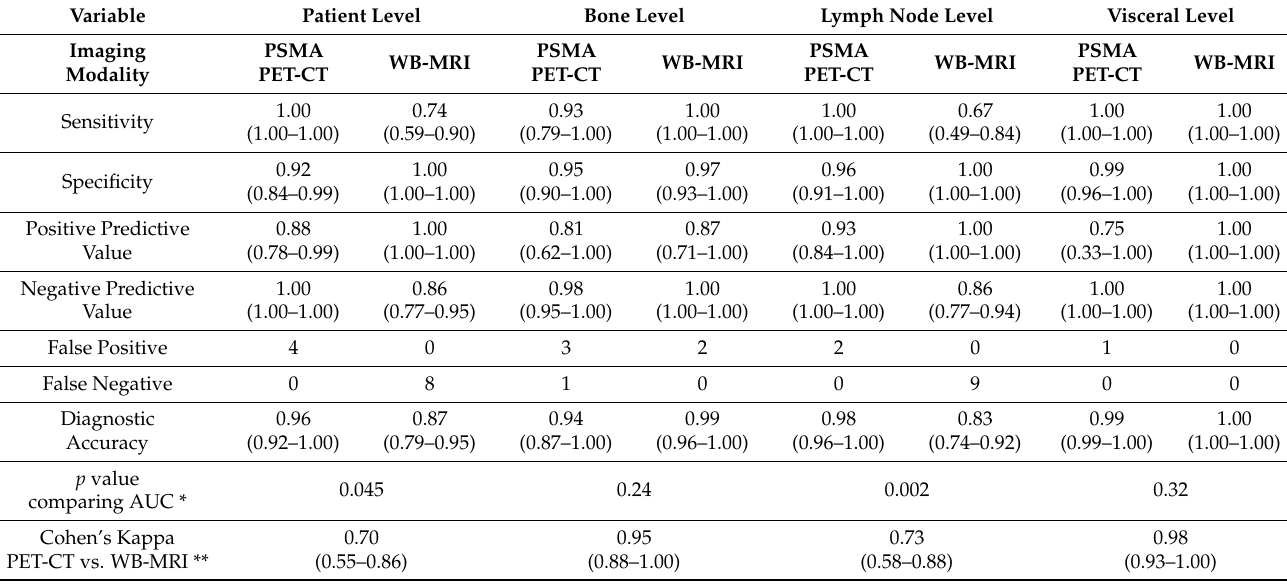
Table 4. Comparison of the diagnostic effectiveness of WB-MRI and PSMA PET-CT in 81 newly diagnosed prostate cancer patients.